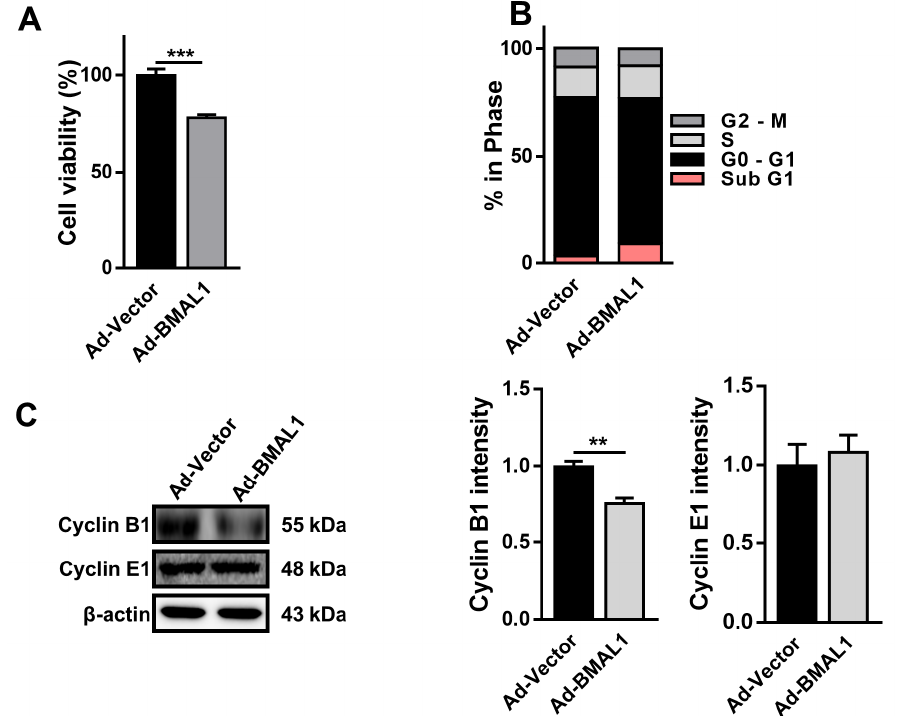
Figure 5. Cell proliferation was decreased in Ad-BMAL1 virus-infected U87MG cells via Figure5. CellproliferationwasdecreasedinAd-BMAL1virus-infectedU87MGcellsviadownregulation downregulation of cyclin B1 and increased apoptosis. ( A ) U87MG cells were infected with control ofcyclinB1andincreasedapoptosis. ( A )U87MGcellswereinfectedwithcontrolandBMAL1adenovirus and BMAL1 adenovirus for 48 h, and cell viability was measured using MTT assay. Data are for 48 h, and cell viability was measured using MTT assay. Data are expressed as the mean ± SEM expressed as the mean ± SEM (Student’s t -test, *** p < 0.001 vs. Ad-vector, three independent (Student’s t -test, *** p < 0.001 vs. Ad-vector, three independent experiments). ( B ) Cell cycle analysis was performed as described in Figure 2B. These are representative data from three independent experiments. ( C ) Lysates from control- and BMAL1 virus-infected U87MG cells were used to determine the level of cyclin B1 and cyclin E1 by Western blotting. Data are expressed as the mean ± SEM (Student’s t -test, ** p < 0.01 vs. Ad-vector, three independent